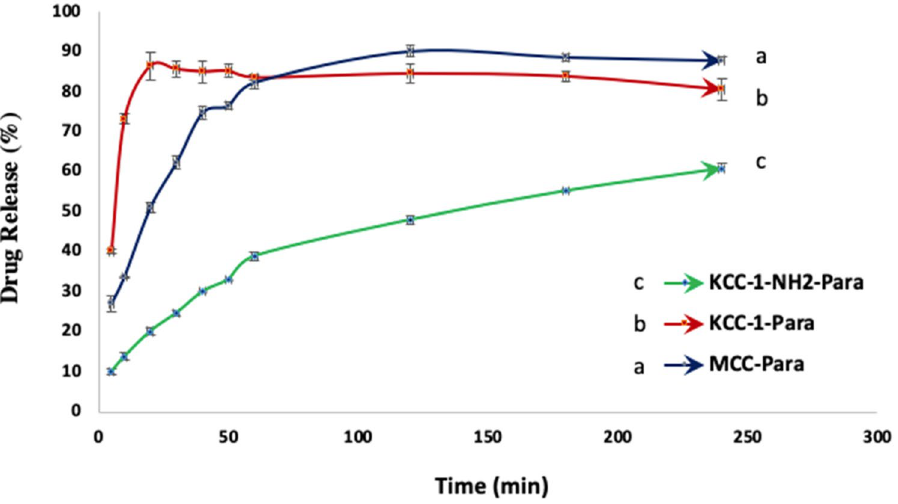
Figure 8. Release rate of paracetamol from MCC-Para, KCC-1-Para and KCC-1-NH 2 -Para tablet at pH